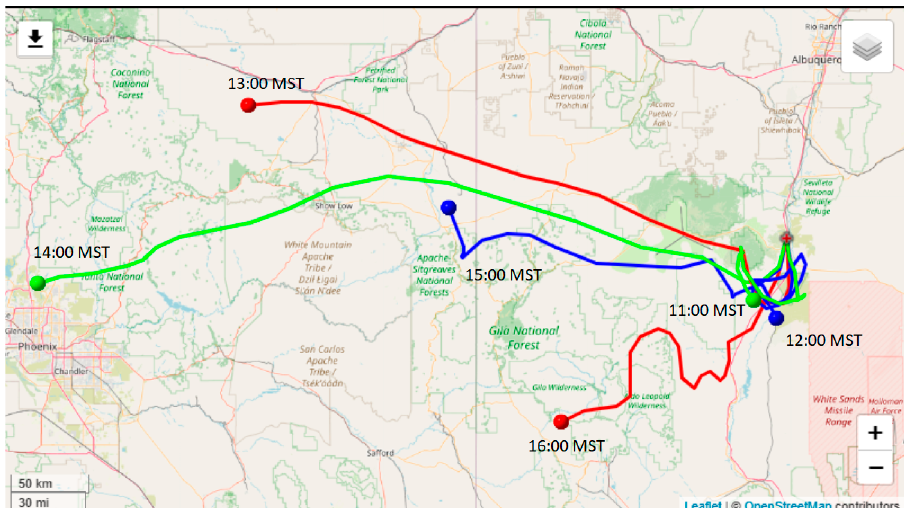
Figure 5. NOAA HYSPLIT model 24-h back trajectories arriving at the receptor site during the smoke episode on 28 November 2018 (six trajectories arriving on the hour from 11:00 to 16:00 MST). The local wind data for 28 November 2018 are shown in Figures 6 and 7 as a wind rose and time series, respectively. During the hours of the haze event in Socorro, local winds shifted to south-southeast beginning around 10:00 MST. and lasting until approximately 18:00 MST. The transport time was ~1.5 h from the IMPROVE site to the receptor site at windspeeds during the late morning. Elevated PM 2.5 concentrations followed the wind pattern quite closely, also showing that the local nature of the event was likely confined to the Rio Grande Valley where diurnal up- versus down-slope atmospheric flow occurred. Prescribed fire impacts may be identified due to their discrete, often single-day nature, and isolated due to their small-scale and targeted nature as suggested in other studies [35].